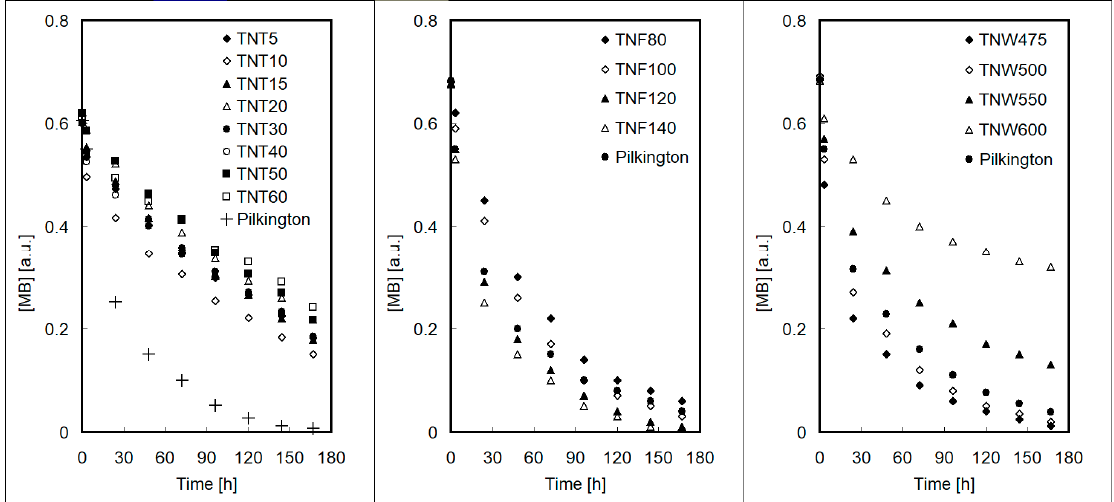
Figure 9. Absorbance-time data for methylene blue photodegradation for titania nanotubes (TNT), nanofibers (TNF), and nanowires (TNW).